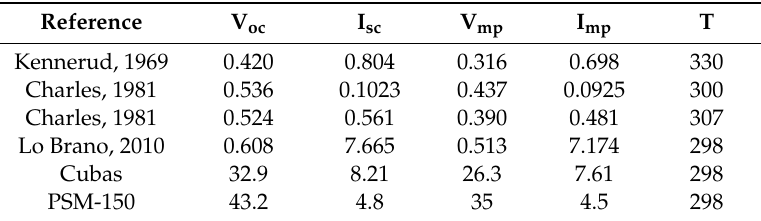
Table 3. I–V curve data (short circuit V = 0, I = I sc , open circuit V = V oc , I = 0, and the maximum power V = V mp , I = I mp points; the slopes of the I–V curve at the open circuit and short circuit points) of several solar cells [41].